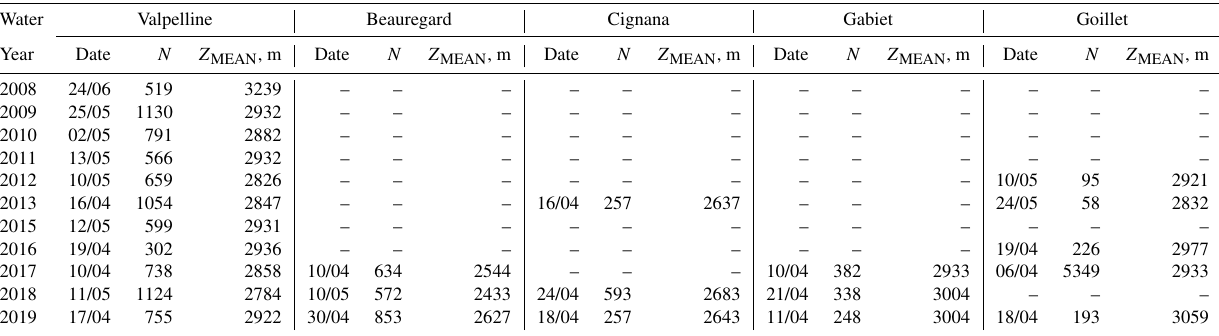
Table 1. Inventory of available snow course surveys, including survey date (day/month), number of samples per survey ( N ), and mean survey elevation ( Z MEAN ). Only a subset of the five areas was surveyed every year, due to budgetary and logistical constraints. The spatial distribution of these samples is shown in Figs. S2–S12 in the Supplement. Note that 2641 out of 5349 measurements collected at Goillet in 2017 were performed on 10 April. Snow courses for this area and water year were part of a large intercomparison workshop, and hence, this explains the much larger sample size than other years and areas. Note: m – meters. Water